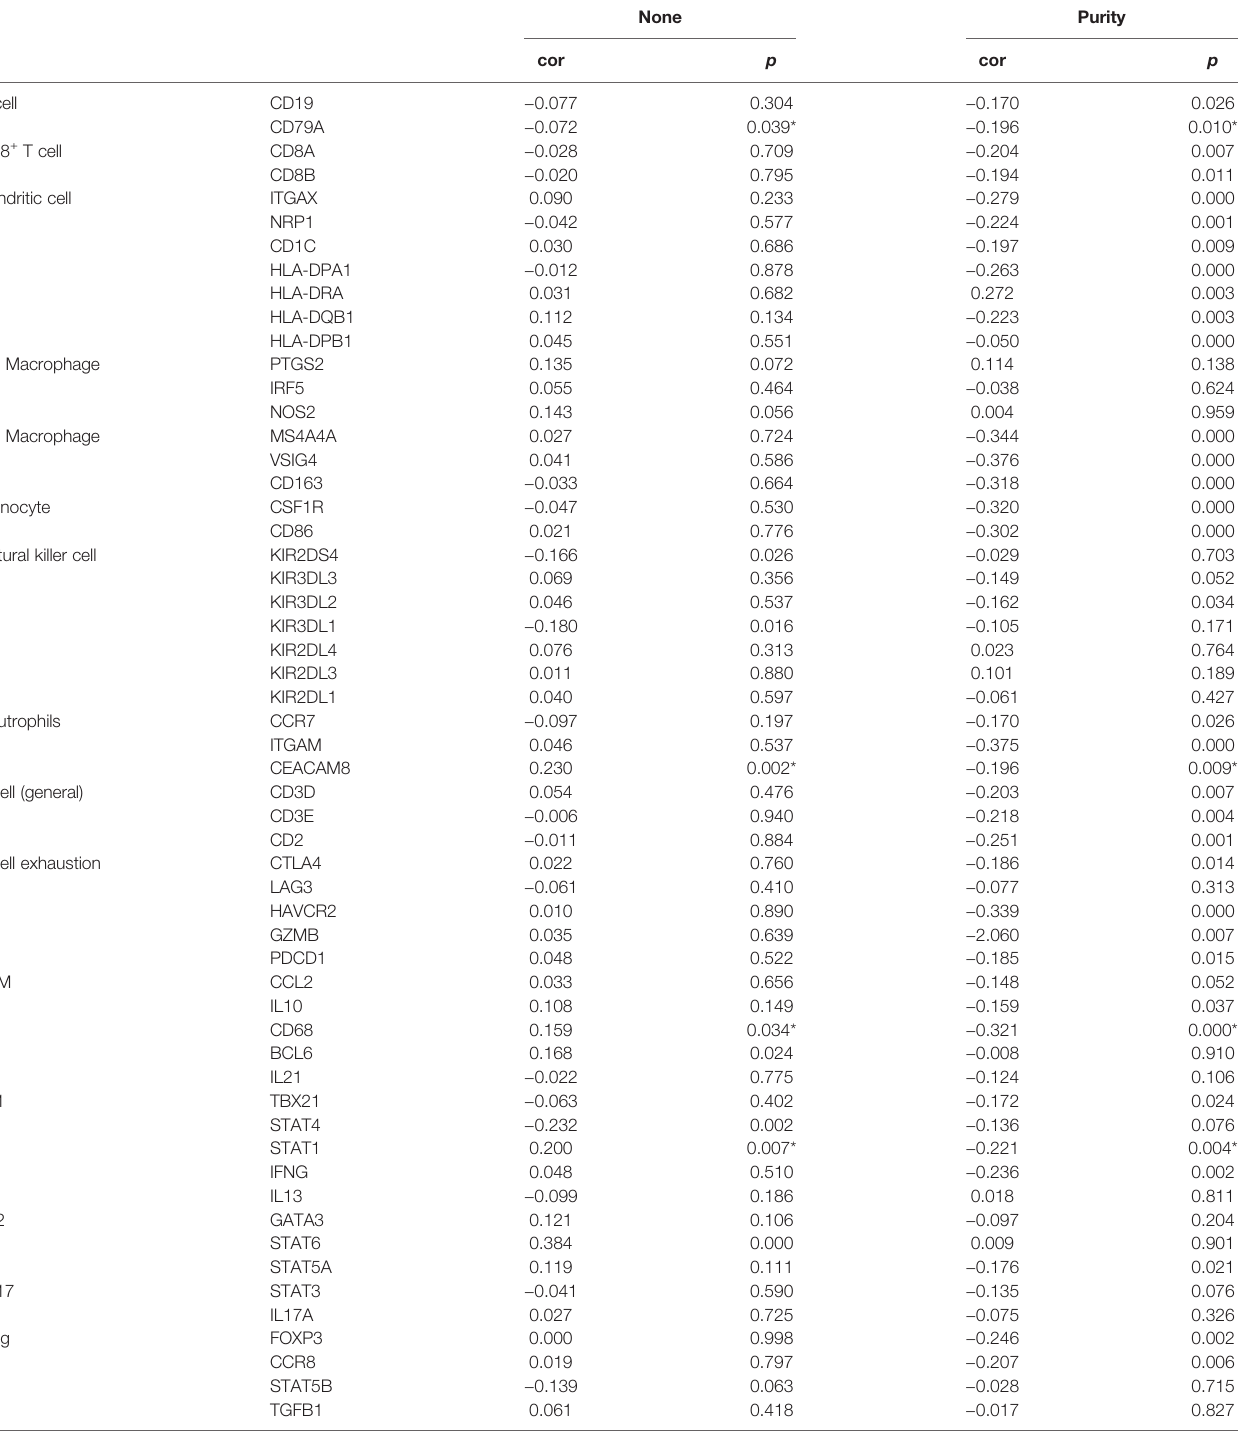
TABLE 3 | The correlation analysis between AQP5 expression and immune cell-associated gene markers in PAAD. None Purity cor p